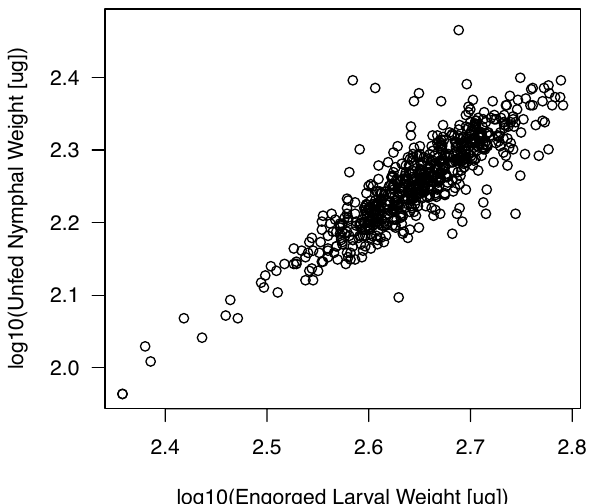
Figure 4. The weight of the unfed I. ricinus nymphs depends on the weight of the engorged larvae. The engorged larval weights and unfed nymphal weights were measured ~ 10 weeks apart for a sample of 653 immature I. ricinus ticks. The positive relationship between the log10-transformed unfed nymphal weights (μg) and the log10-transformed engorged larval weights (μg) is highly significant (r = 0.854, t = 41.859, df = 652, p <